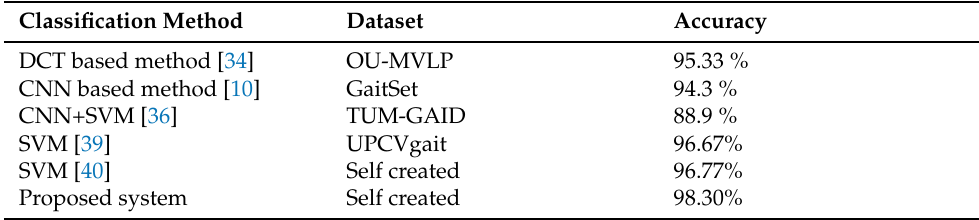
Table 10. Comparison of the proposed model with other gait-based gender classification